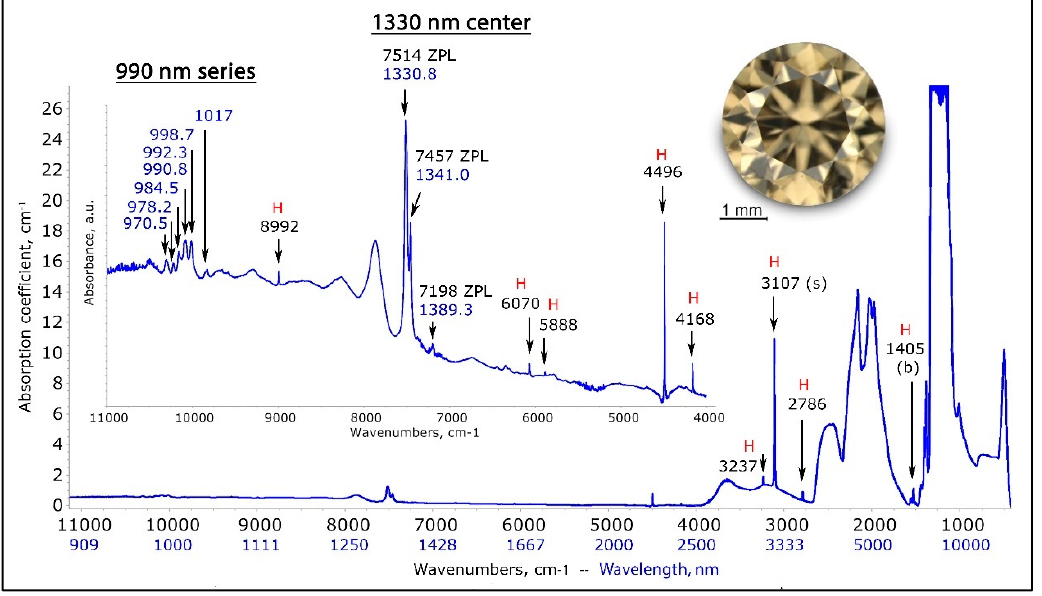
Figure 15. The normalized near to mid-infrared spectrum (range 900 to 25,000 nm) of a NDR hydrogen- and nitrogen-rich type IaA >> B diamond (TH 2.618) exhibits the typical hydrogen-related sharp absorption (indicated with a red “H”), plus a very distinct 1330 nm center and the domain from 4000 to 11,200 cm − 1 was recorded with the diamond at 77 K.